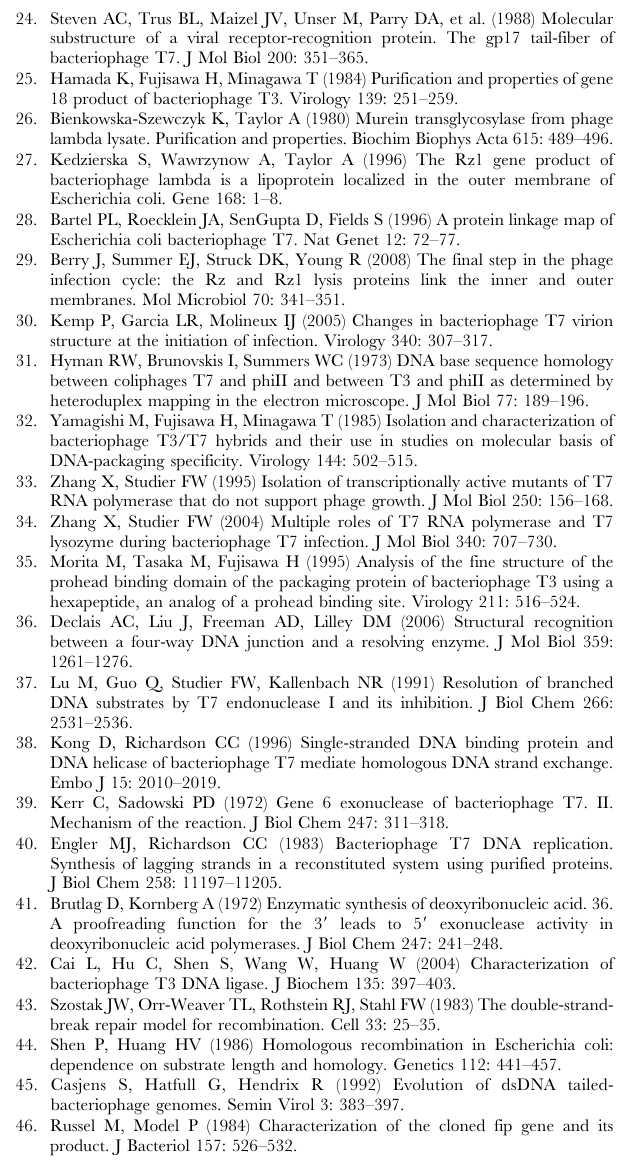
DNA. Gene 5 from both phages were cloned to a T vector by primers 19–20, and sequenced by primers 21–25. Table S3 Restriction sites and fragment sizes of T3 and T7 DNA. The positions of restriction sites and sizes of fragments generated by restriction endonucleases on T3 and T7 DNA based on published sequences. (DOC) Table S4 Sequenced positions of phage T7M. The numbering of nucleotides (2 nd column), as well as the genes, promoters ( w ), terminators (T), and RNase III sites (R) (3 rd column), follows that of phage T3L. If a gene is not completely sequenced, the number of nucleotides sequenced from 5 9 , 3 9 or the middle (mid) of the gene is indicated inside the parenthesis. In all sequenced positions, only nt 22151 and nt 22169 are different from T3. Both incur a T R C change in gene 10B . (DOC)